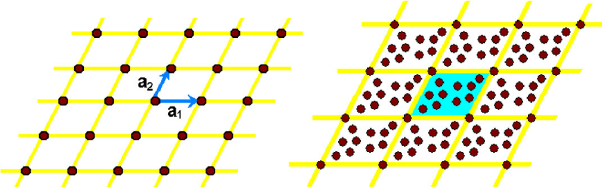
FIG. 3. (Bravais) lattice with one particle per fundamental cell (left panel) and a periodic crystal with multiple particles per fundamental cell (right